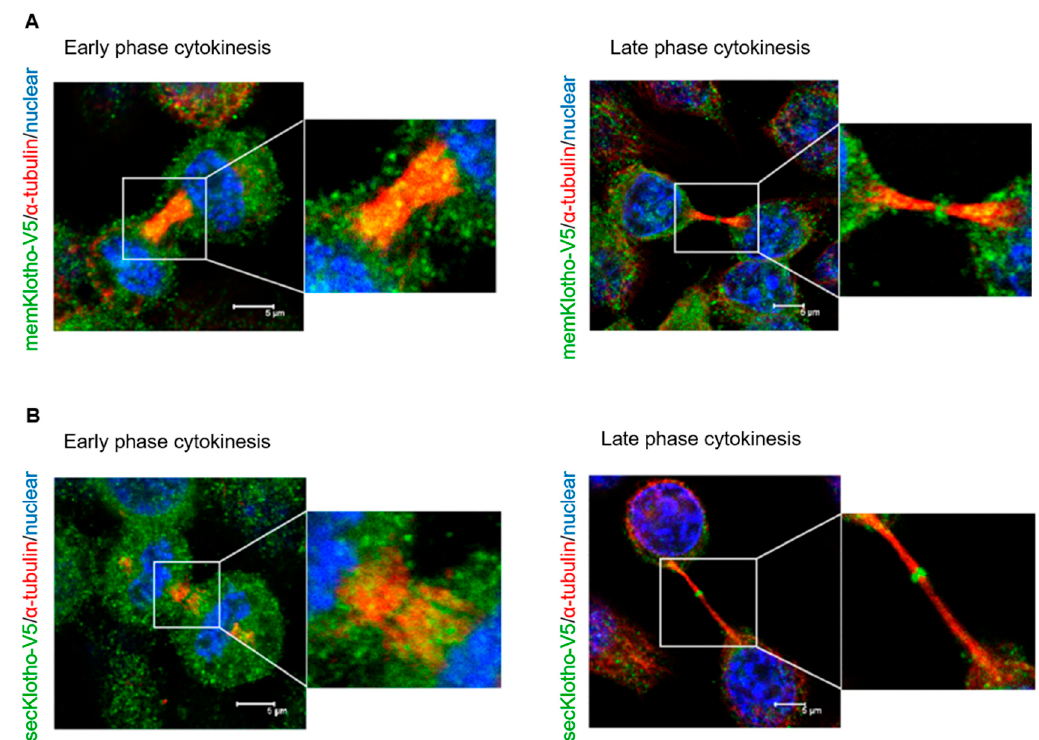
Figure 4. Cellular localization of secreted and membrane Klotho proteins during cytokinesis. Cultured HeLa cells transfected with memKL-V5 ( A ) or SecKL-V5 ( B ) expression plasmids for 24 h were analyzed by immunofluorescence with an anti-V5 antibody. The representative images of early and late cytokinesis are shown (memKL-V5: membrane Klotho; SecKL-V5: secreted Klotho; microscopy: ×400).